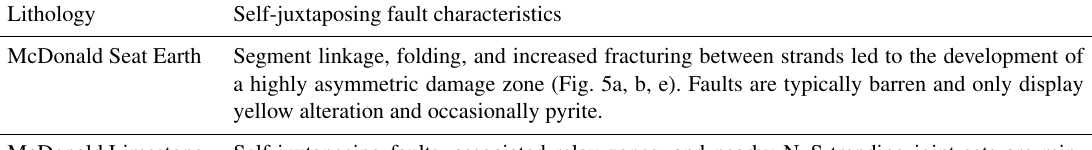
Table 1. Self-juxtaposed fault characteristics by lithology. Lithology Self-juxtaposing fault